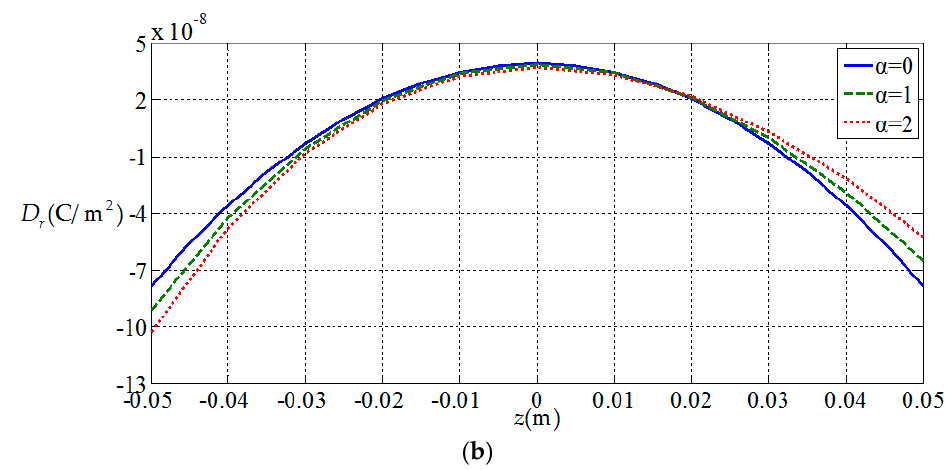
Figure 8. Variation of electric displacement with coordinates z . ( a ) Electric displacement at the periphery of plate D z ( 1, z ) ; ( b ) electric displacement at the periphery of plate D r ( 1, z ) .